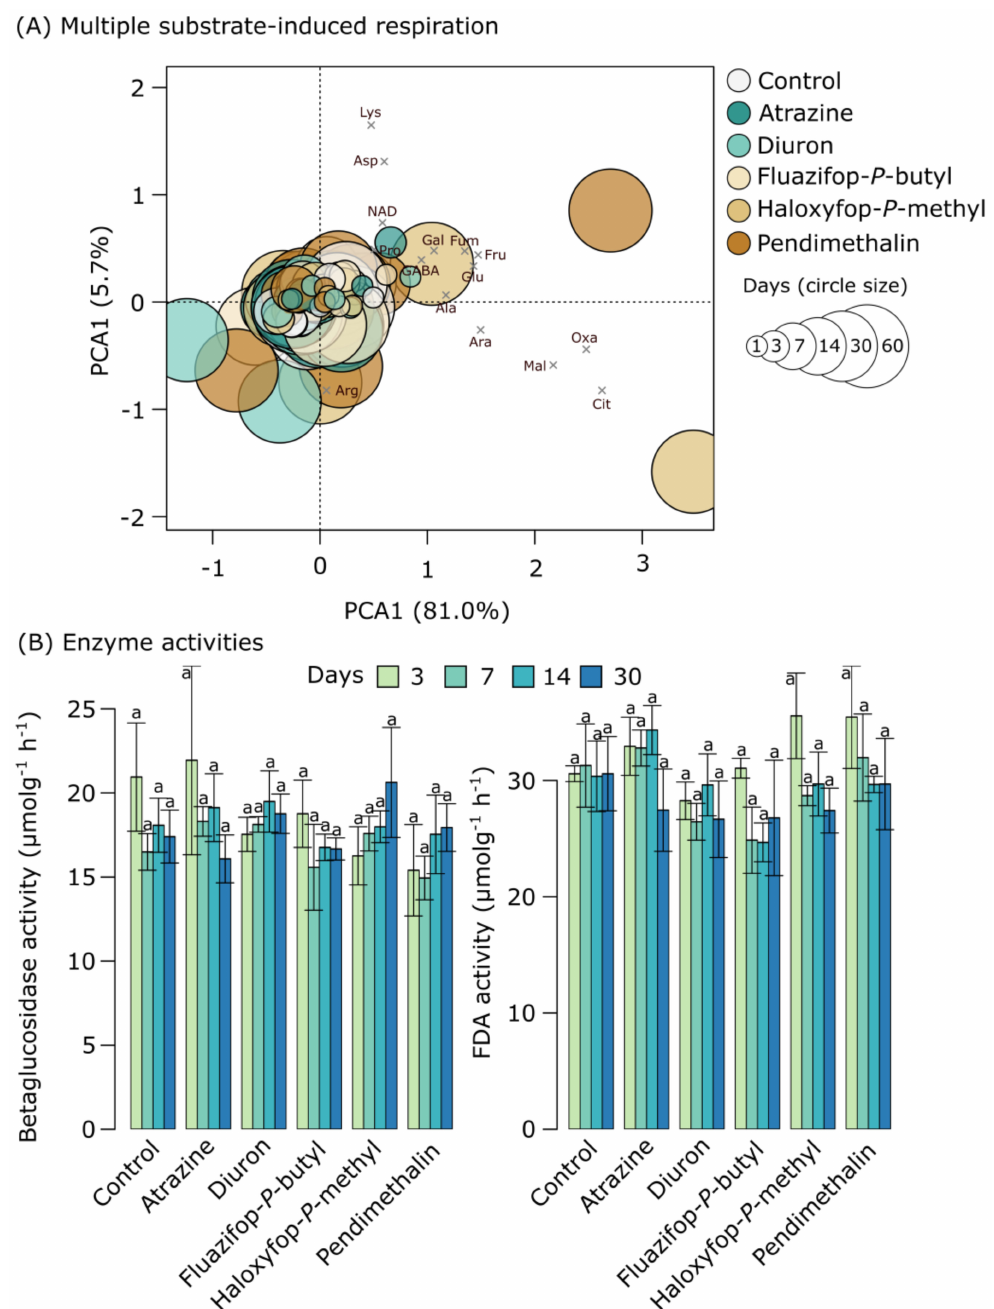
Figure 2. ( A ) An ordination highlighting differences in the respiratory responses of soil microbial communities to the addition of 15 different substrates as measured using MicroResp. ( B ) Bar plots representing the mean betaglucosidase and FDA activity in each treatment over time. Error bars represent standard errors of the means, and the letters above the bars indicate significant differences ( p < 0.05) between treatments according to ANOVA with post hoc Tukey